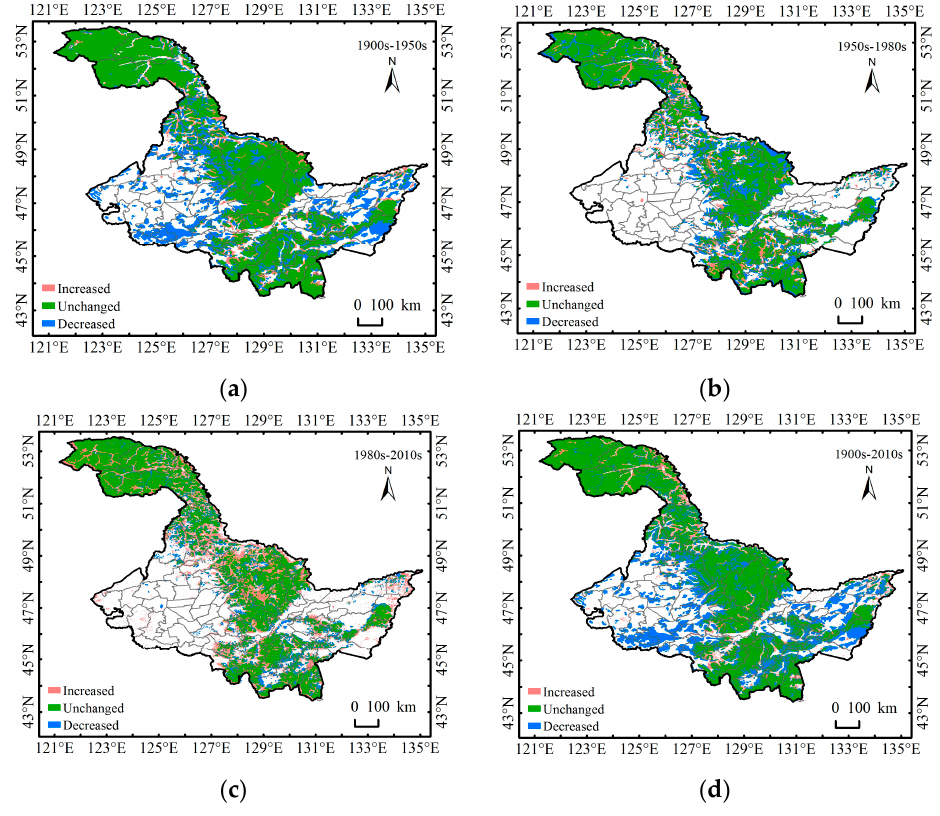
Figure 4. Maps showing the spatial distribution of forest change in Heilongjiang Province between ( a ) the 1900s and the 1950s; ( b ) the 1950s and the 1980s; ( c ) the 1980s and the 2010s; and ( d ) the 1900s and the 2010s.